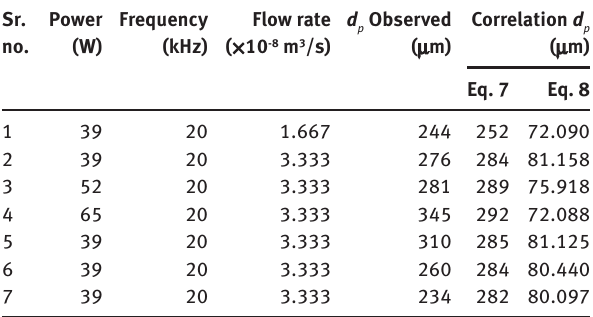
Table 2: Comparison between droplet size predicted by correlations (Eqs. 7 and 8) and experimental observation. Sr.